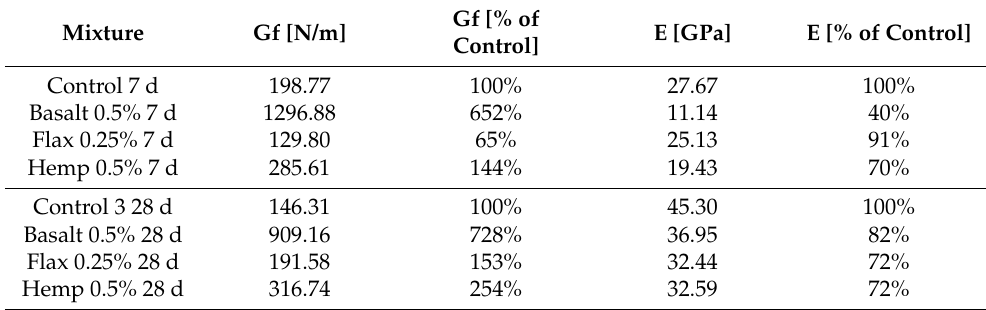
Table 8. Fracture energy and elastic modulus of FRC.